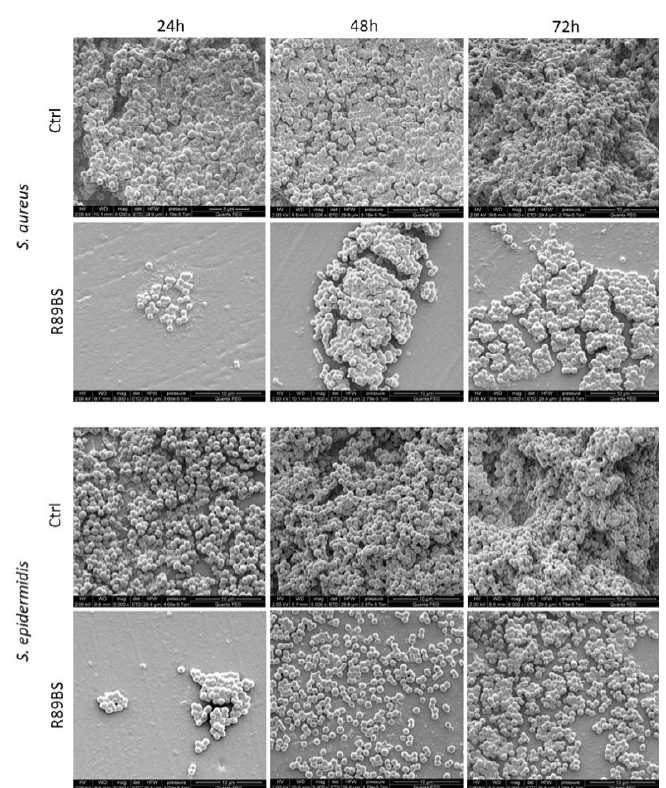
Figure 6. Micromorphology of the biofilm on the SED surface. Coccoid microbial cells and an extracellular matrix were present at the SED surface in different amounts according to incubation time (24 h, 48 h, and 72 h) and type of sample (Ctrl: uncoated controls; R89BS: coated silicone discs). A three-dimensional architecture was also revealed in control samples at incubation times longer than 24 h. Images were captured using scanning electron microscopy, high vacuum mode (primary